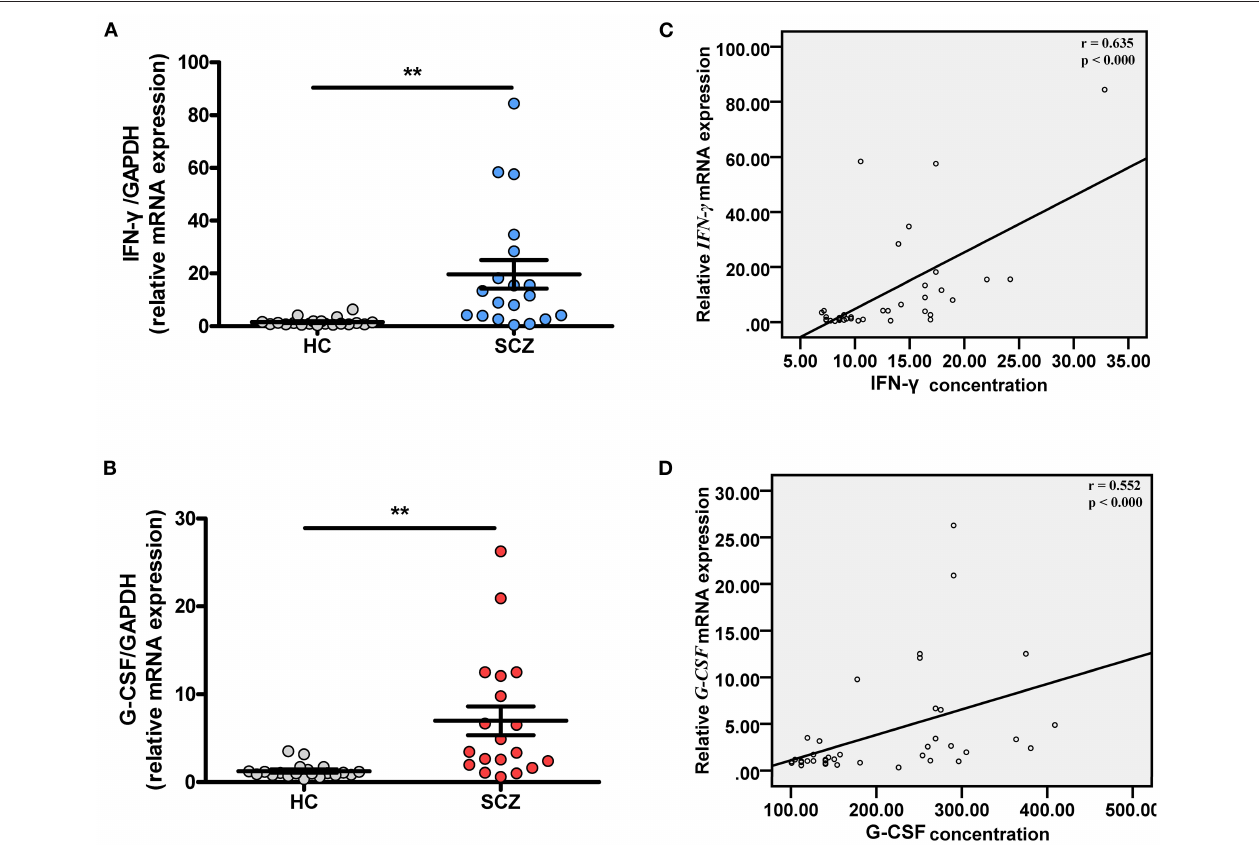
FIGURE 3 | Transcriptional expressions of G-CSF and IFN- γ in FEDF patients with SCZ and HC subjects. Blood IFN- γ (A) and G-CSF (B) mRNA levels are significantly increased in FEDF patients with SCZ when compared with HC subjects. Pearson’s correlation analysis shows that IFN- γ (C) and G-CSF (D) mRNA levels ware highly correlated with their respective protein concentrations. SCZ, schizophrenia; FEDF, first-episode, drug-free; HC, healthy control; IFN, interferon; G-CSF, granulocyte colony-stimulating factors; ** P <